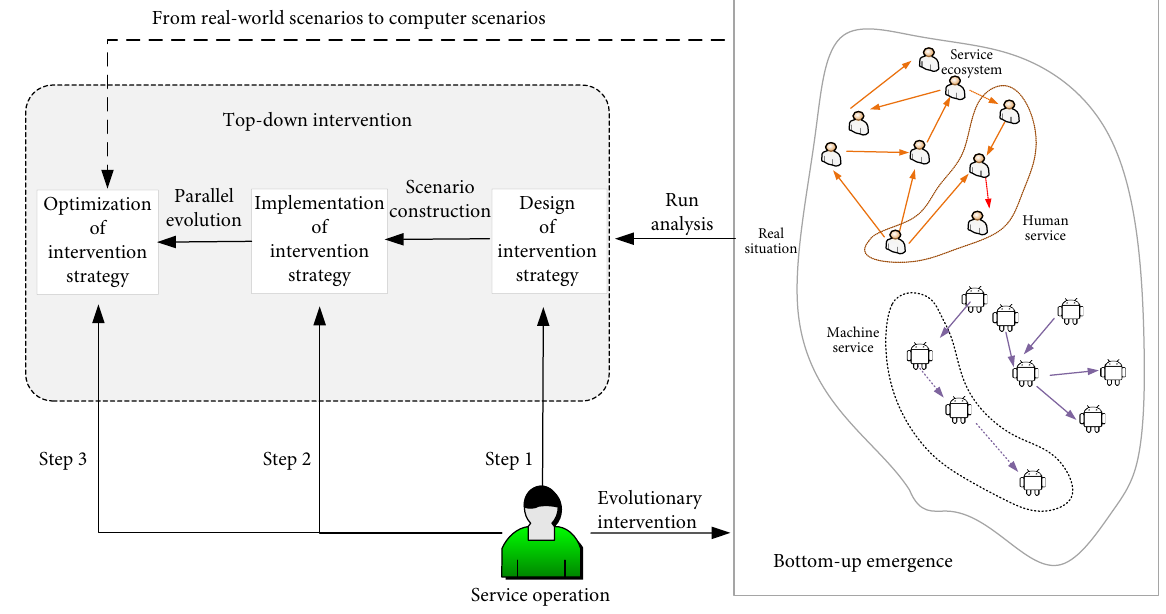
Fig. 10 Intervention model of the service